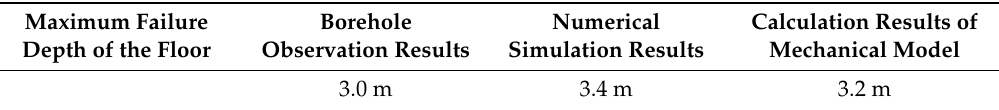
Table 2. Analysis and comparison of the maximum failure depth of the